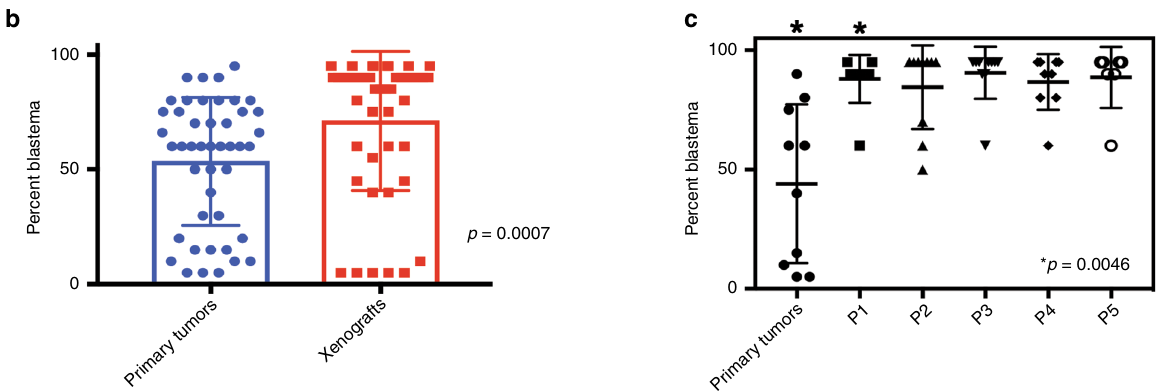
Fig. 3 Early-passage WTPDX enrich for blastema by histology. a The percentage of blastema is plotted for primary tumors (triangles) versus corresponding early-passage xenografts (circles), demonstrating that most xenografts enrich for the blastemal component by histology. b A signi fi cant increase in the percentage of blastema by histology was found when the entire group of primary tumors versus early-passage xenografts were compared. c The percent blastema was compared between nine triphasic primary tumors and the fi rst fi ve passages of corresponding WTPDX (P1-P5). A signi fi cant increase in percent blastema was found at the fi rst passage and maintained through passage 5. Error bars in b and c represent mean ± standard deviation. P values are from a paired two-tailed t